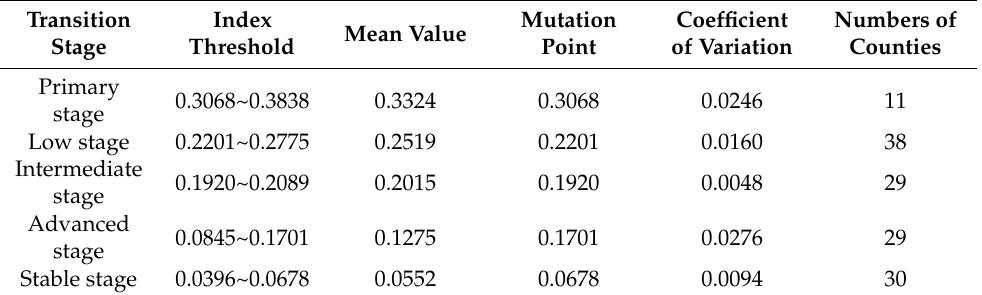
Table 3. Mathematical statistics of the rural residential transition index in Shandong